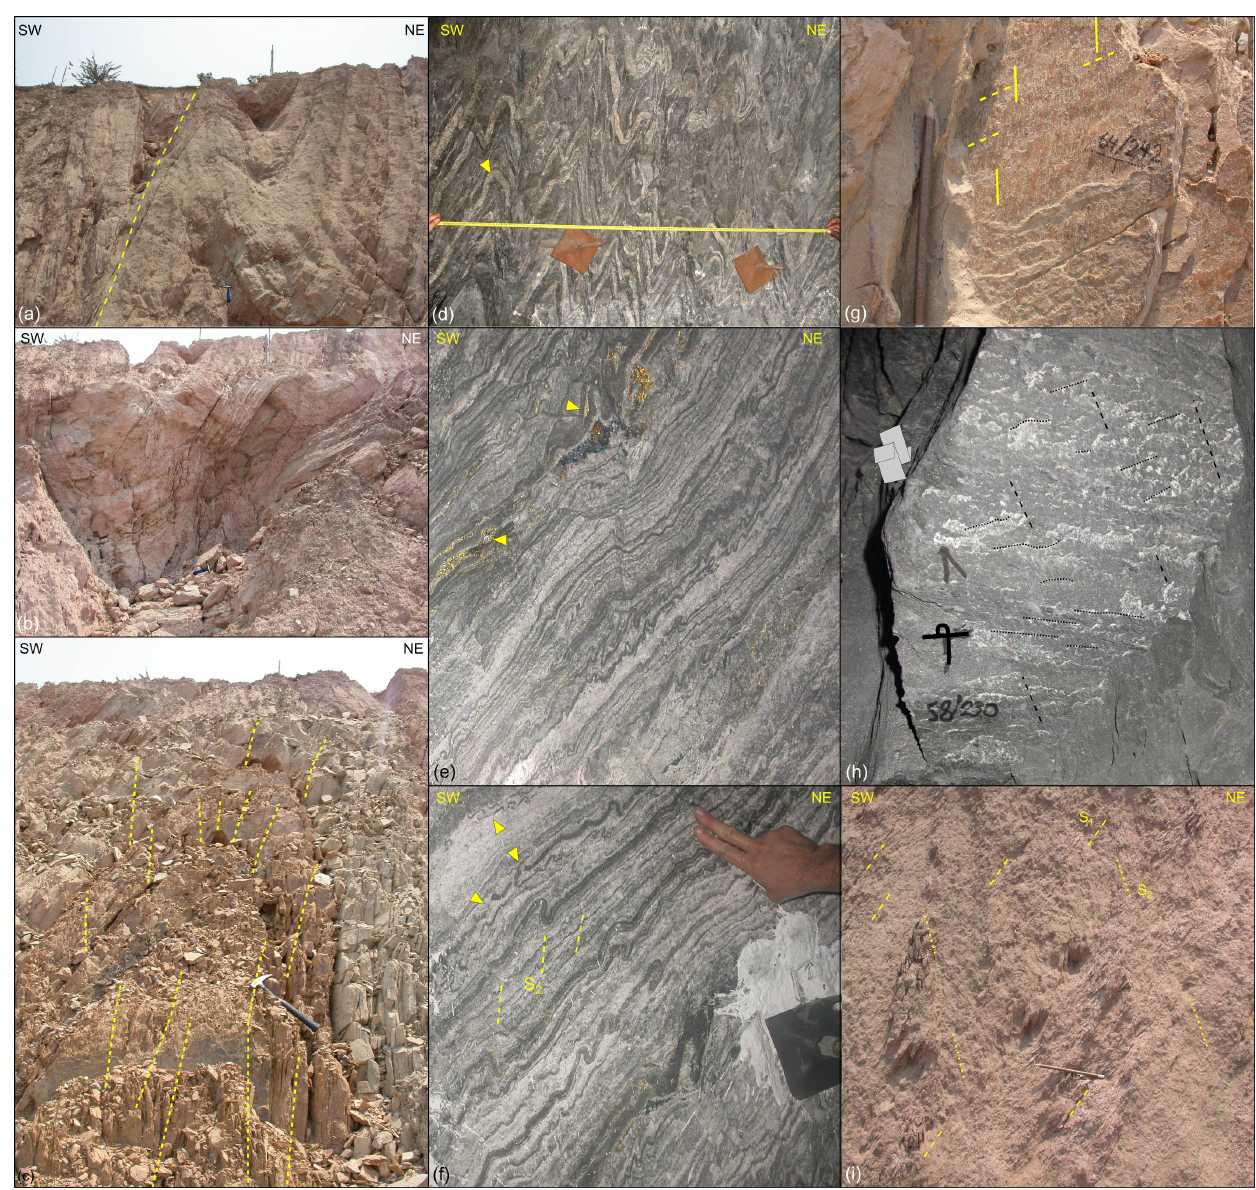
Figure 6. Structural observations at Chambishi–Nkana. See Supplement for detailed locations. (a–c) Third-order folds in the Rokana Evap- orites Member. (a) A steep (reverse?) fault developed on the limb of a third-order fold. (b) Third-order parasitic folding in sandstones with a wavelength of around 1m. (c) Slightly NE-verging anticline. Almost no cleavage refraction can be observed between beds of the Rokana Evaporites Member. (d–f) Fourth-order folding in the COM. (d) High-amplitude folding of bedding-parallel veins in the carbonaceous mu- drock lithofacies in section 7. Folds are tight chevron folds, spacing between veins is 2 to 10cm. (e–f) Intraformational folding of siliciclastic layers (mudstone, siltstone) in dolomite in unit 5 of the argillaceous dolomite at Mindola. The multilayer folding is polyharmonic to dishar- monic. The orientation of the tectonic cleavage is subvertical or steeply NW dipping. Chalcopyrite and bornite occur disseminated and in patches. Occasionally, siliciclastic beds are laterally interrupted or broken up (arrows). (g) Dolomite slickenfibres parallel to S 1 cleavage in the limb of a third-order fold developed in the Rokana Evaporites Member in the Nkana South open pit (section 8). Slickenfibre steps reveal reverse slip and the slickenline lineation (pitch of 80; full lines) is sub-orthogonal to the local π axis to S 1 cleavage plunging 9 ◦ westwards. Slickenfibre step lineations (dashed lines) plunge 35 towards 312. (h) Dolomite slickenfibres with steep slickenline lineations (dashed lines) on a S 1 cleavage plane in the limb of a second-order fold developed in the COM. The pitch of the dolomite slickenfibre steps (dotted lines) is 26 on the overturned S 1 plane 58/230 in the carbonaceous mudstone in section 6. (i) Carbonaceous mudrock lithofacies of the COM showing a strong bedding-parallel shaly S 1 foliation. A gentle axial planar tectonic cleavage S 2 is developed, by discontinuous alignment of micas and sulfides. The rock is therefore an argillite. Pencil for